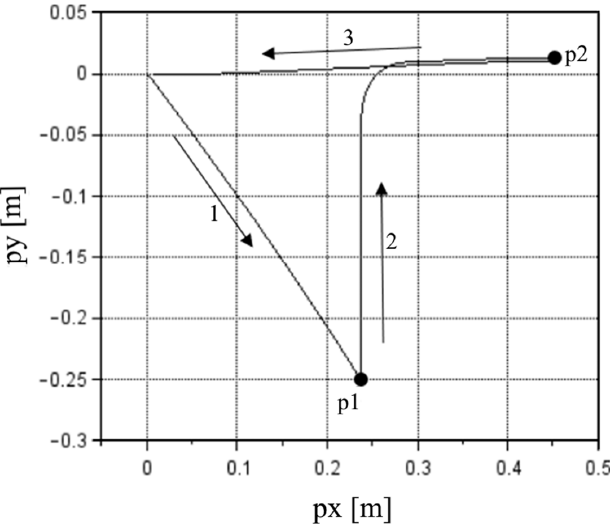
Figure 3. Nozzle route: The first stop is at the feeder at p1, and the second stop (p2) is at the camera. Route based on the results for the first cycle at 100% MS using the optimized values. : At p1, the machine executed the pickup of the component; therefore, there was ver- tical motion while the machine was stopped. However, that motion is not analyzed in this work.